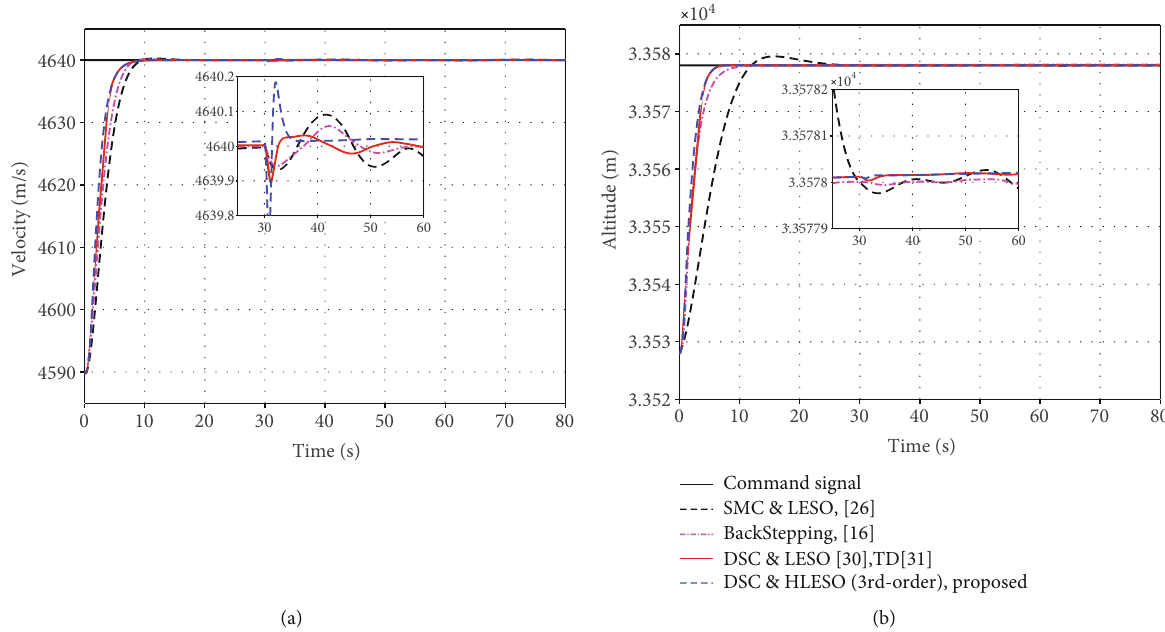
Figure 3: Velocity and altitude response curves: (a) velocity channel and (b) altitude channel.